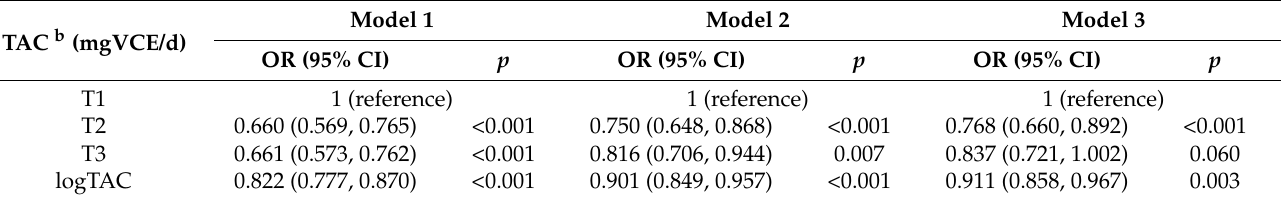
Table 4. Sensitivity analysis of relationship between total antioxidant capacity and the risk of stroke by interpolation of missing data a